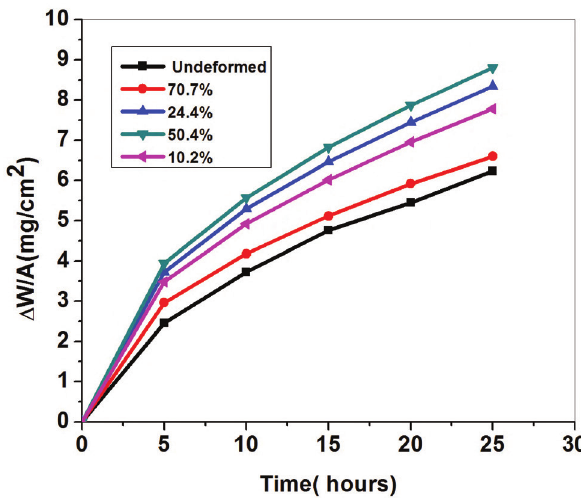
Fig. 3: Corrosion growth rate and reaction kinetics of different cold worked specimen at 923 K in SO 2 +O 2 (ratio 2:1) environment for 24 hours